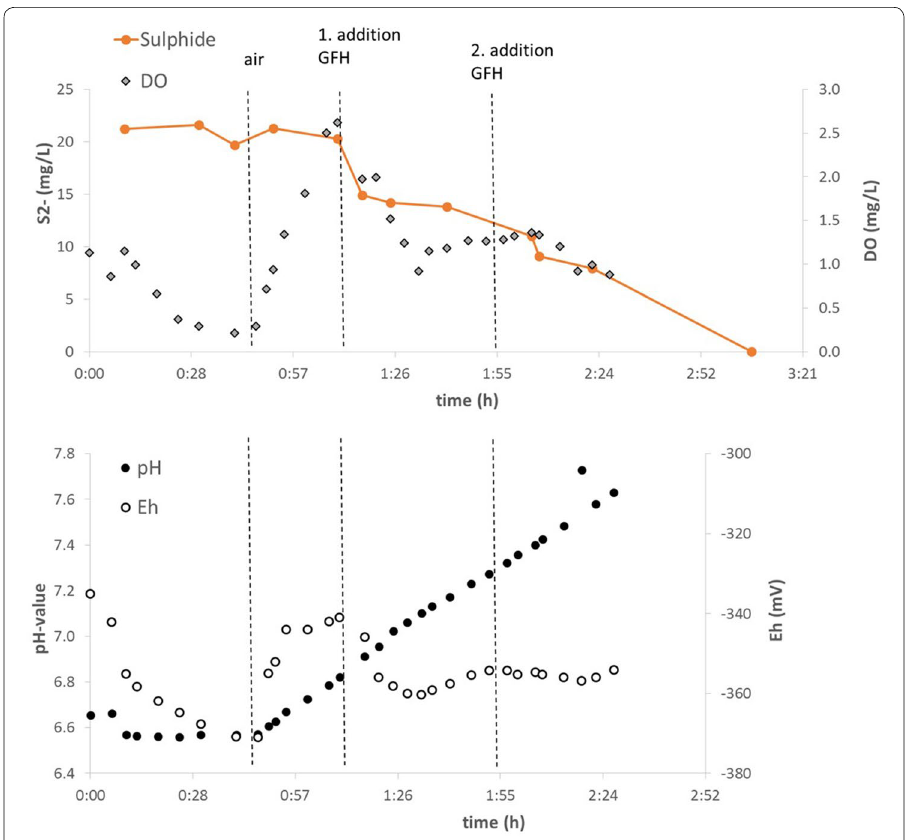
Fig. 4 Change of sulfide, DO (top), and redox and pH value (bottom) over time in dependence of the experimental conditions (experiment C), measured in the outflow of the reaction container. GFH was added twice as marked in the